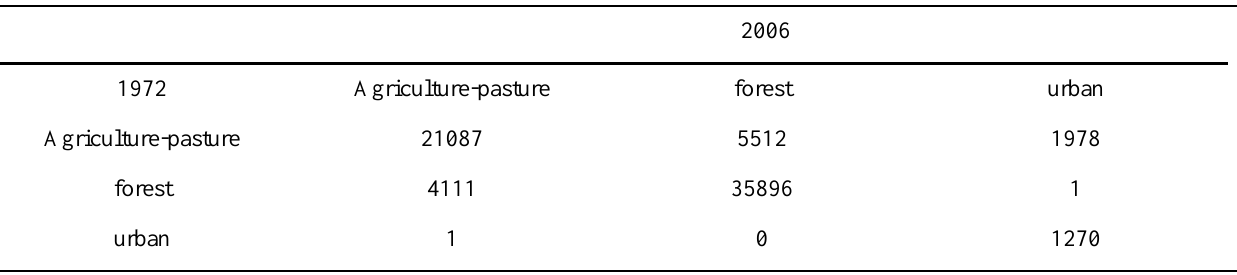
Table 1. Transition matrix (in hectares) of main land-cover types between 1972 and 2006 in the study